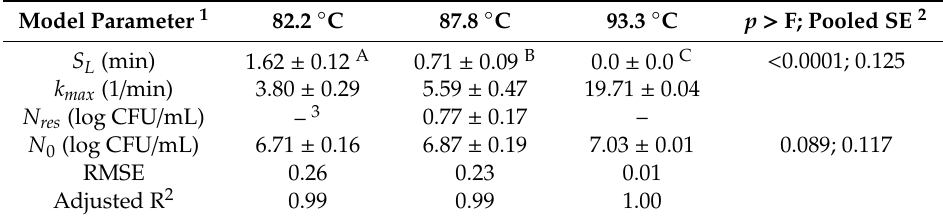
Table 2. Least squares means of lethality model parameters for Salmonella inoculated into and heated in whole chicken blood.